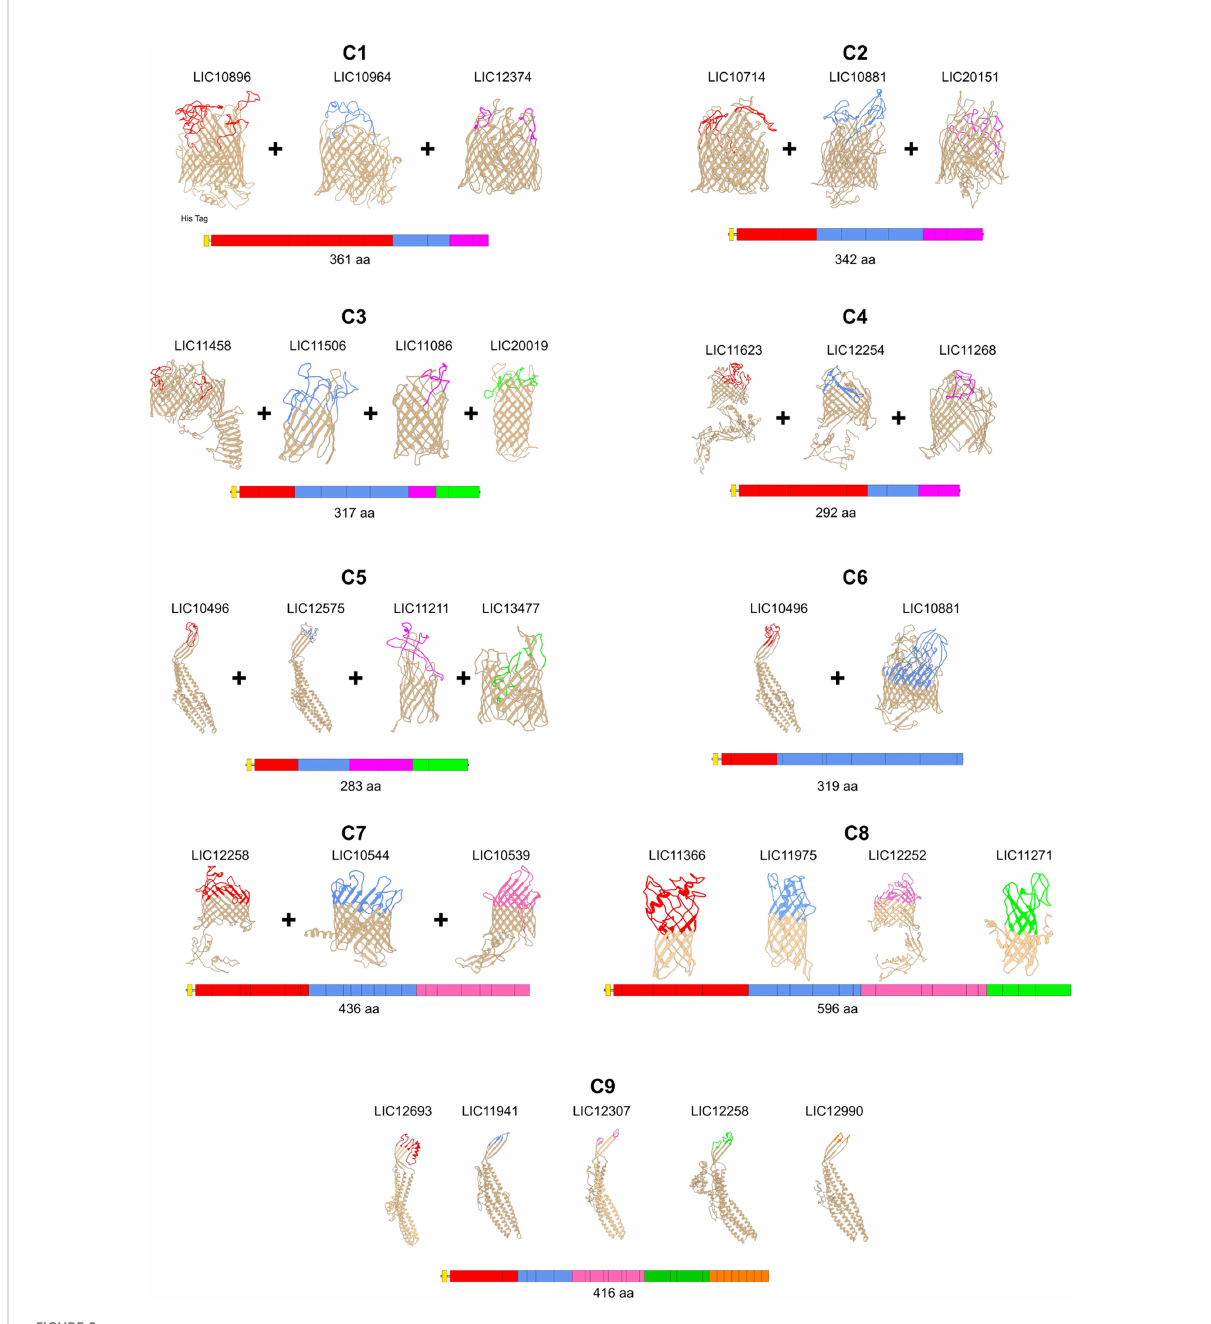
FIGURE 2 Predicted 3D models of the chimeric leptospiral b -barrel OMPs and mapping of the surface-exposed regions. Chimeras containing combinations of surface-exposed regions are shown. The 3D models were determined using I-TASSER and the images were generated using UCSF Chimera software. The orientation of the b b-OMPs in the OM was derived from an interpretation of the best matching PDB structure. The upper, surface-exposed regions are shown in colour on the 3D models and these regions were used in the design of the recombinant proteins. The horizontal bars under the 3D models are a graphical representation of the composition of the